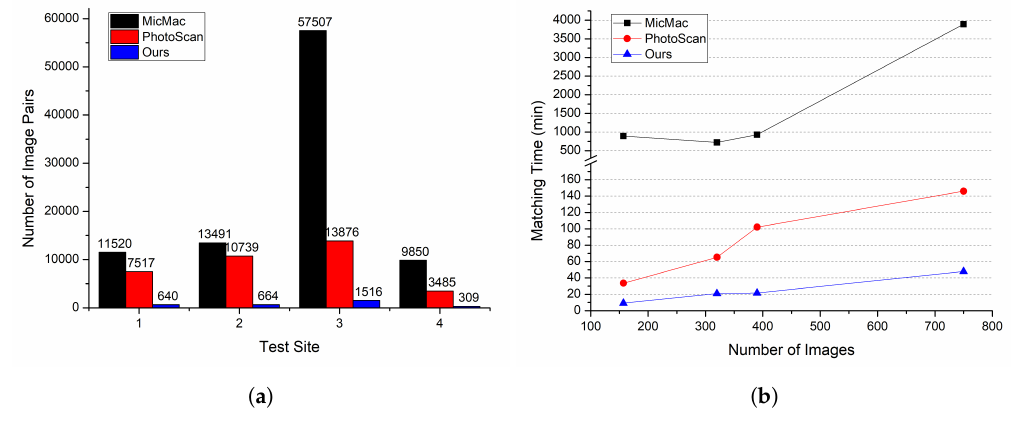
Figure 12. Efficiency comparison: ( a ) number of image pairs; ( b ) time costs of feature matching.